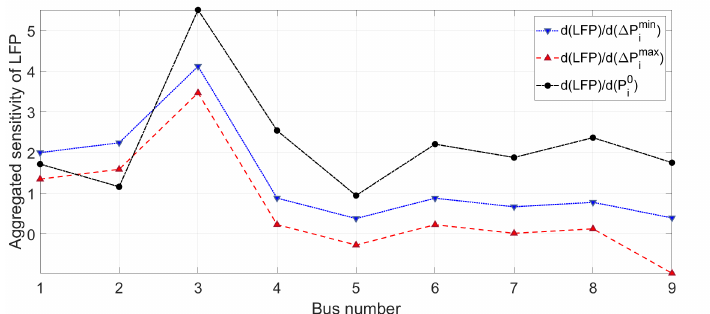
Figure 5. Aggregated impact of perturbations in lower and upper bound of flexibility (blue and red lines), and base-power program (black line) at each bus on the LFPs for the network in Case